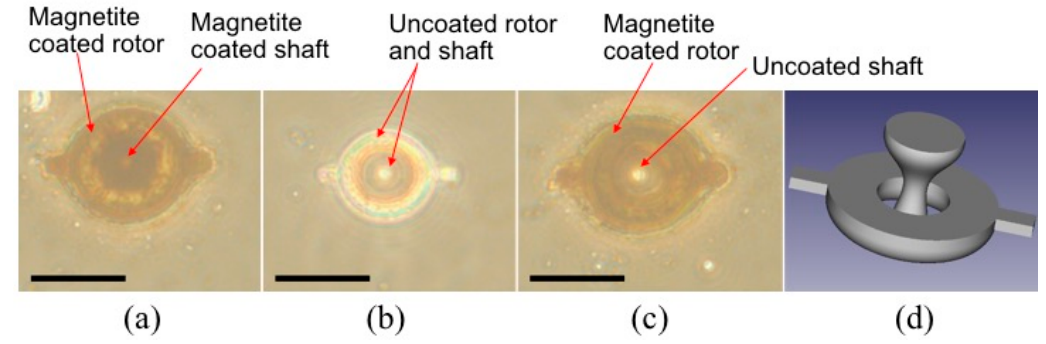
Figure 5. Experimental demonstration of selective magnetite coating of microrotors. ( a – c ) Optical images of fully coated acrylic rotor and shaft, uncoated methacrylic rotor and shaft, and selectively coated acrylic rotor with uncoated methacrylic shaft. Scale bar is 25 µm. ( d ) 3D CAD model of the microrotor.